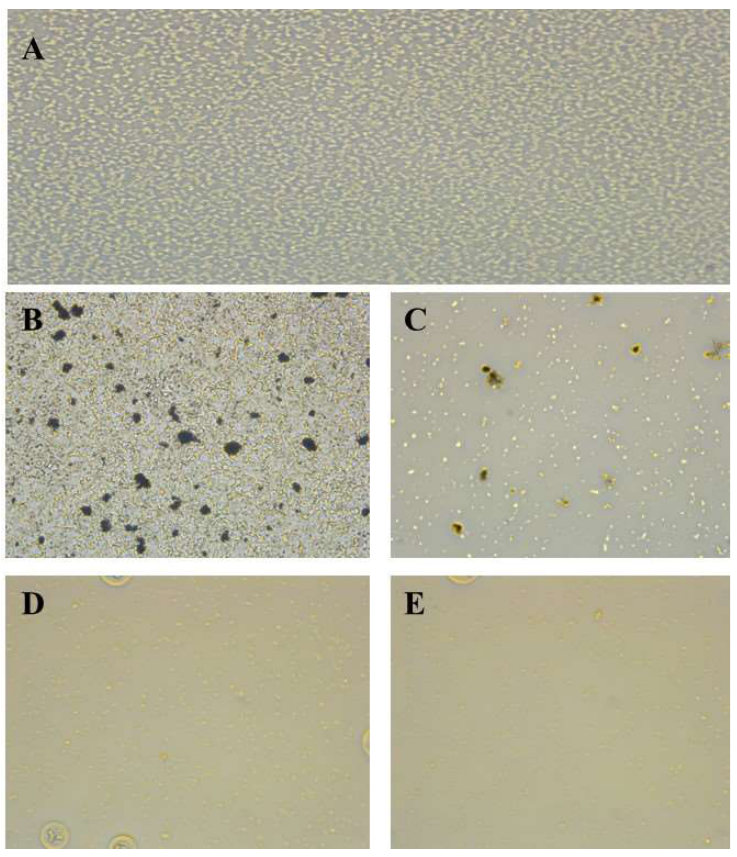
Figure 8. Results observed under inverted microscope (40x) ( A ). Pseudomonas aeruginosa Biofilm untreated, ( B ). Pseudomonas aeruginosa inhibition treated with NDG (100 µg/mL), ( C ). Pseudomonas aeruginosa inhibition treated with NDG (200 µg/mL), ( D ). Pseudomonas aeruginosa inhibition treated with ampicillin (1000 µg/mL), ( E ). Pseudomonas aeruginosa inhibition treated with ampicillin (2000 µg/mL).